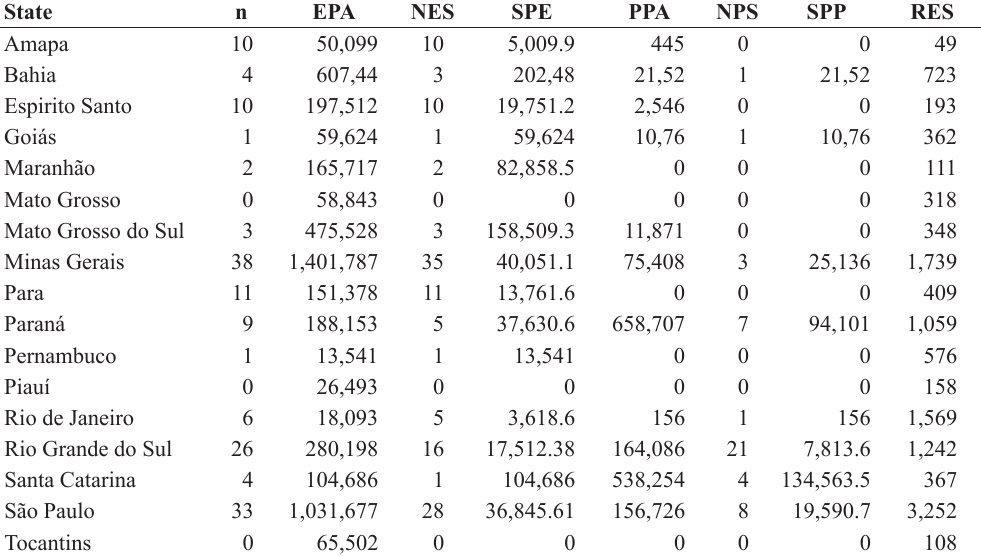
number of studies in each Brazilian state (n). Where: EPa = area planted with Eucalyptus s pp. (ha) (aBraf 2012); nEs = number of studies found for Eucalyptus s pp. plantations; sPE = ratio of area planted with Eucalyptus s pp. per study; PPa = area planted with Pinus s pp. (ha) (aBraf 2012); nPs = number of studies found for Pinus s pp. plantations; sPP = ratio of area planted with Pinus s pp. per study; rEs = number of researches (caPEs 2013).